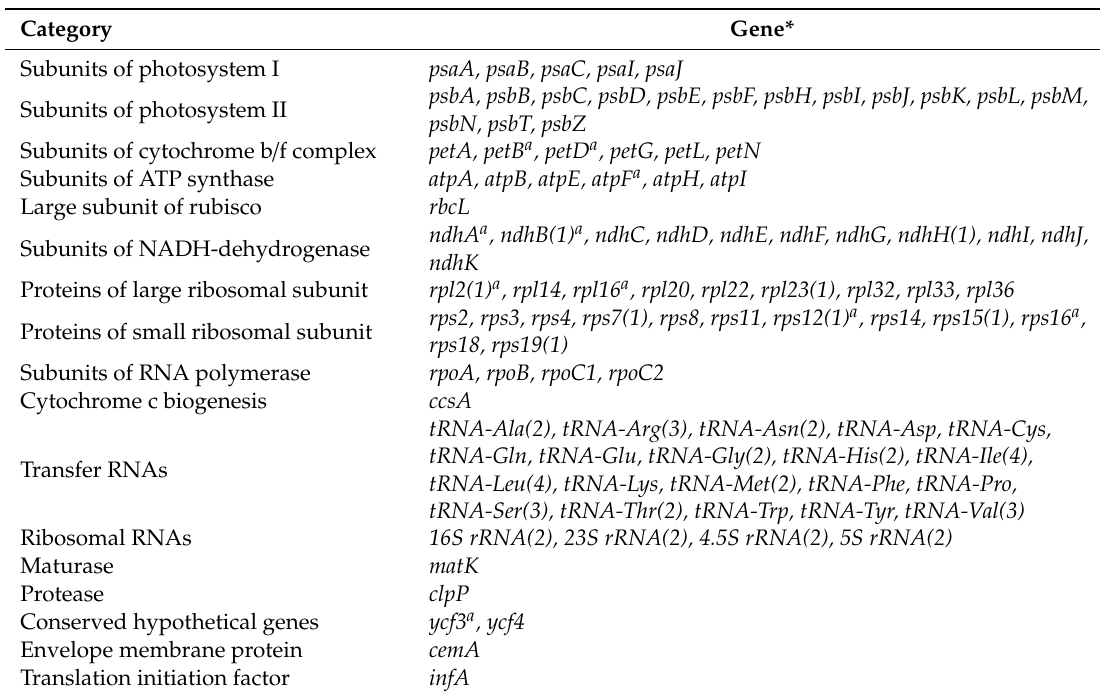
Table 2. List of 130 genes and their duplications found in the plastids of 25 Avena species.